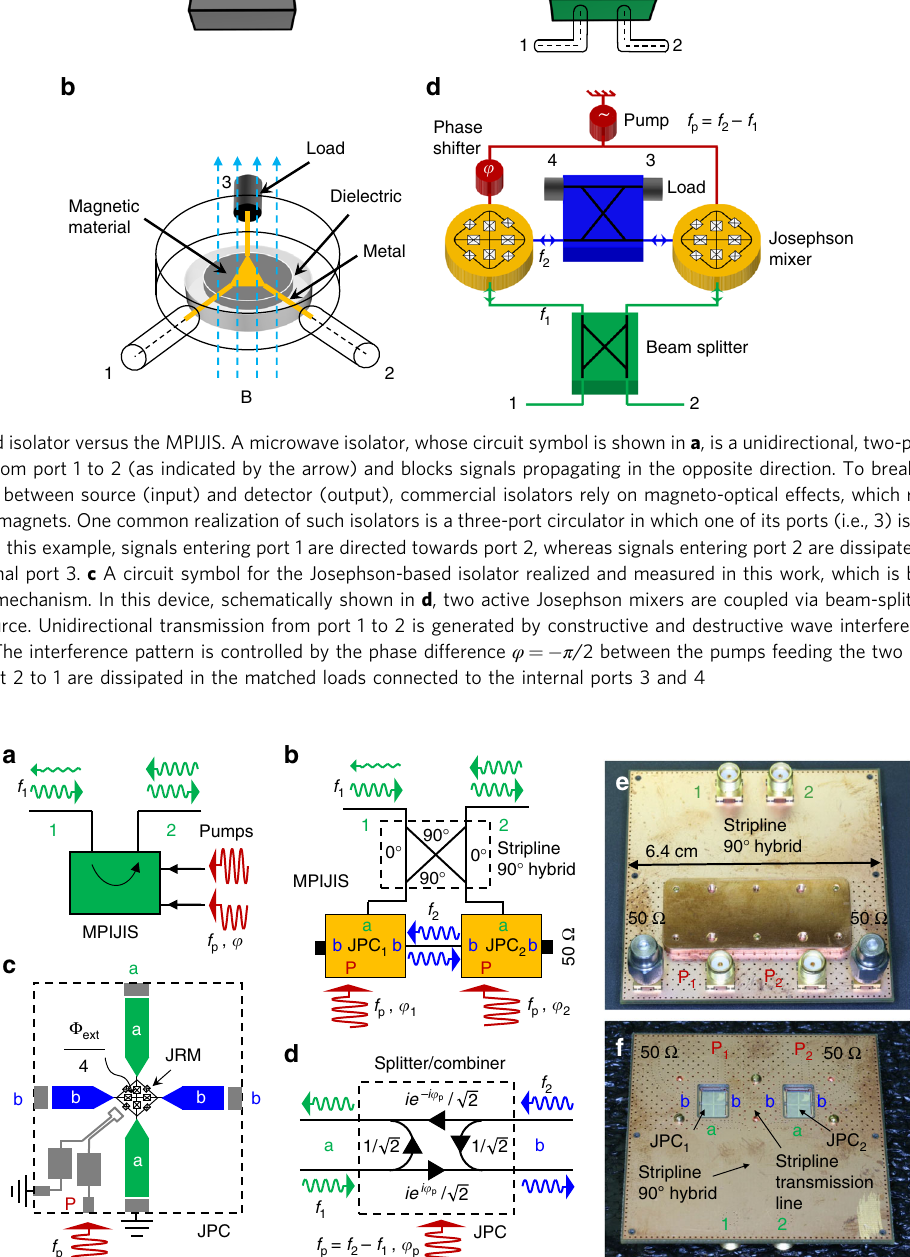
Fig. 2 The MPIJIS device. a Black-box illustration of the MPIJIS operation. The MPIJIS receives two microwave drives (pumps) at the same-frequency f p having a certain balanced amplitude and phase difference φ = − π /2. The MPIJIS transmits signals within the device bandwidth, e.g., f 1 , from port 1 to 2 with almost unity transmission, while signi fi cantly attenuating signals propagating in the opposite direction. b Block-circuit diagram of the MPIJIS measured in this work. The device consists of two Josephson parametric converters (JPCs), whose ports ‘ a ’ and ‘ b ’ are coupled by a 90° hybrid and a short transmission line, respectively, forming an interferometric setup for propagating signals at frequencies f 1 and f 2 . One side of port ‘ b ’ of each JPC is terminated with a matched 50 Ω cold load forming the internal ports of the device. The pump is fed to each JPC through a separate physical port. c Schematic layout of the JPC employed in the MPIJIS. The JPC consists of two half-wavelength microstrip resonators, denoted as ‘ a ’ and ‘ b ’ , strongly coupled to a JRM. Each resonator is capacitively coupled to one external feedline on either side via gap capacitances. Resonator ‘ a ’ is made single ended by shorting one of its feedlines to ground. The pump is injected to the JRM through an on-chip drive line. d Signal fl ow graph for the JPC operated at a 50:50 beam splitter/ combiner working point, in which half of the input signal, on each port, is re fl ected off and the other half is transmitted to the other port with frequency conversion. The transmitted signal acquires a nonreciprocal phase shift based on the pump phase. e , f exhibit photos of the top and bottom view of the MPIJIS, respectively, realized by embedding two JPC chips into a multilayer printed circuit board, which incorporates a stripline 90° hybrid and transmission lines (the center-conductor of the stripline components is buried and therefore not visible). In f , the bottom cover that encloses the chips is removed to expose the